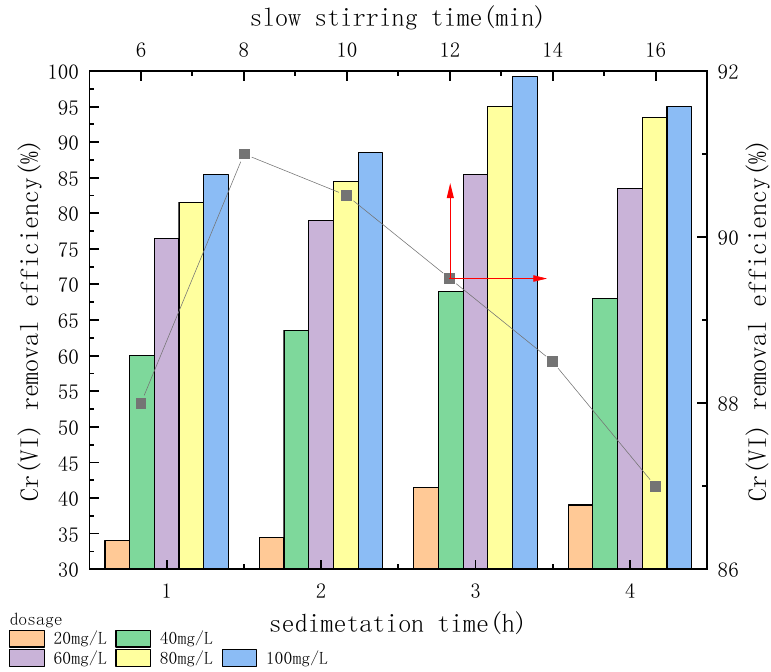
Figure 7. Effect of pH on Cr(VI) removal.